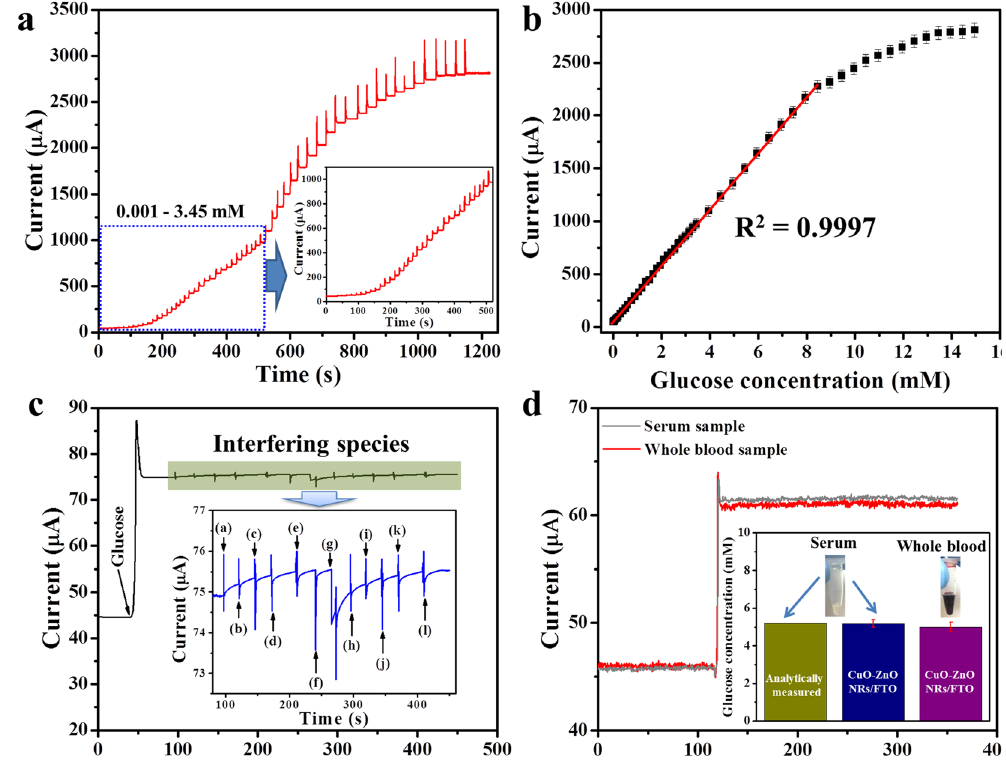
Figure 6. Non-enzymatic detection of glucose. ( a ) Amperometric response of CuO-ZnO NRs/FTO electrode at + 0.62 V (versus Ag/AgCl) in 0.1 M NaOH solution with different glucose concentration from 0.001 to 14.95 mM and inset response curve shows the magnified view of low concentration range of glucose (0.001–3.95 mM). ( b ) Corresponding calibration plot of current response versus glucose concentration. ( c ) Anti-interference ability test. Amperometric response of the CuO-ZnO NRs/FTO electrode with the addition of 0.1 mM glucose and 0.02 Mm of each possible interfering species i.e. (a) AA, (b) UA, (c) DA, (d) NADH, (e) Mg 2 + , (f) Ca 2 + , (g) Cys, (h) NaCl, (i) lactose, (j) sucrose, (k) maltose, and (l) mannose in the 0.1 M NaOH solution at + 0.62 V ( versus Ag/AgCl). ( d ) Real sample glucose detection. Amperometric response of CuO-ZnO NRs/FTO electrode at + 0.62 V ( versus Ag/AgCl) in 9.5 mL 0.1 M NaOH solution after injecting 0.5 mL blood serum (i) and freshly drawn whole human blood (ii). The upper inset shows the photograph of serum and whole blood samples and lower inset shows the histogram of glucose concentration compared with blood chemistry analyzer